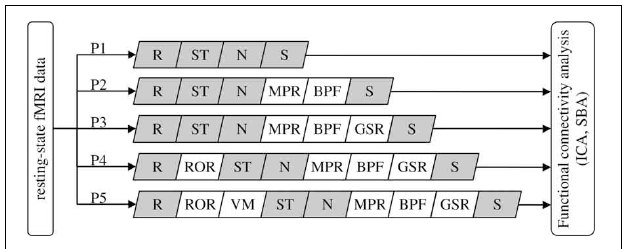
FIGURE 1 | Definition of the data preprocessing pipeline for the five procedures (P1–P5) under comparison. R, realignment; ST, slice-timing correction; N, normalization to MNI space; S, spatial smoothing; MPR, removal of co-variance with movement parameters; BPF, band-pass filtering; GSR, removal of global parenchymal signal; ROR, removal of realignment outliers; VM, ventricle masking. The modules in gray are standard SPM8 functions, the others are functions developed in-house (see